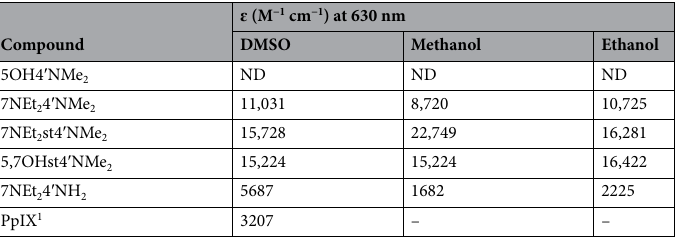
Table 1. Molar absorption coefficient ( ɛ ) for the different compounds by measuring absorbance at λ = 630 nm (maximum wavelength for red light). 1 For PpIX the determination was only performed in DMSO, due to solubility restrictions.